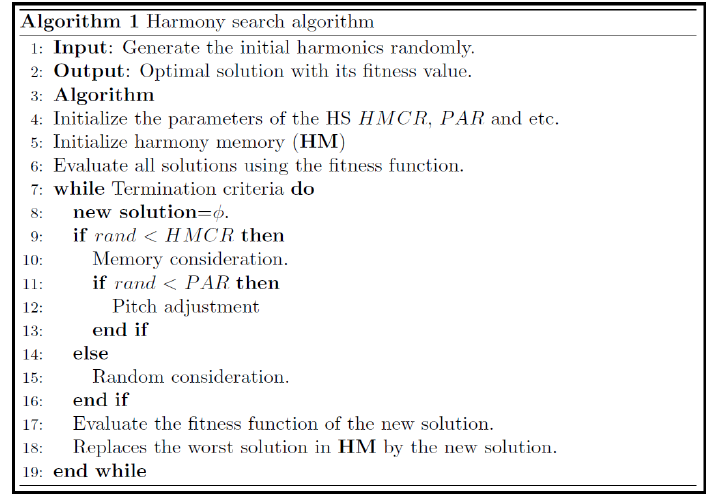
Figure 4. Pseudo-code of the basic Harmony Search (HS)